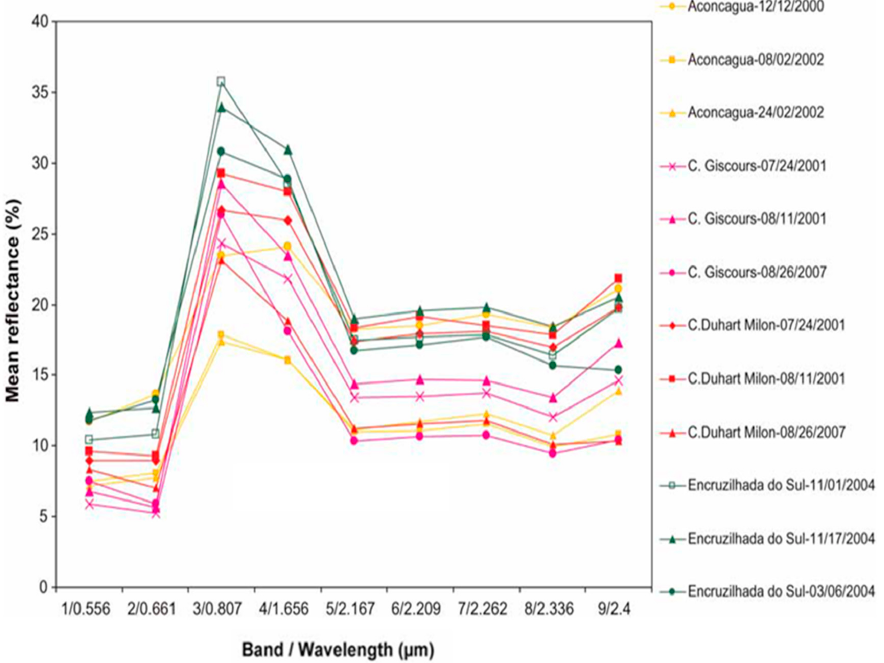
Figure 5. Mean reflectance for Merlot plants in Advanced Spaceborne Thermal Emission and Reflection Radiometer (ASTER) spectral bands [177]. The figure shows the high variability of the spectral response for a given cultivar according to the phenological stage and the production land. The colors correspond to different land.